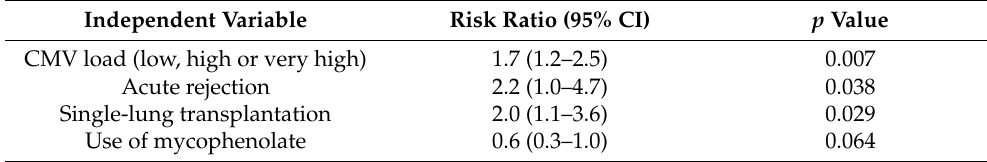
Table 3. Cox regression model to analyse the association of CMV load and acute rejection with